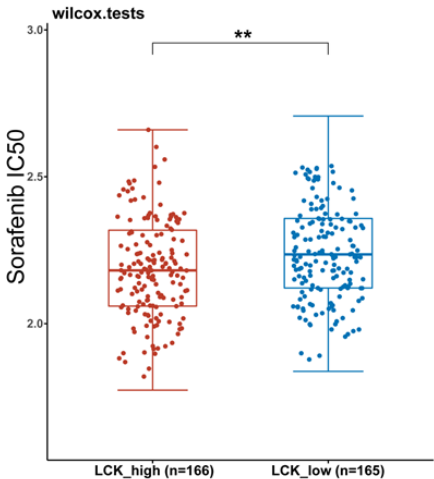
Figure 12. Distribution of the half-maximal inhibitory concentrations of sorafenib in the two LCK expression groups. p < 0.01 = **.